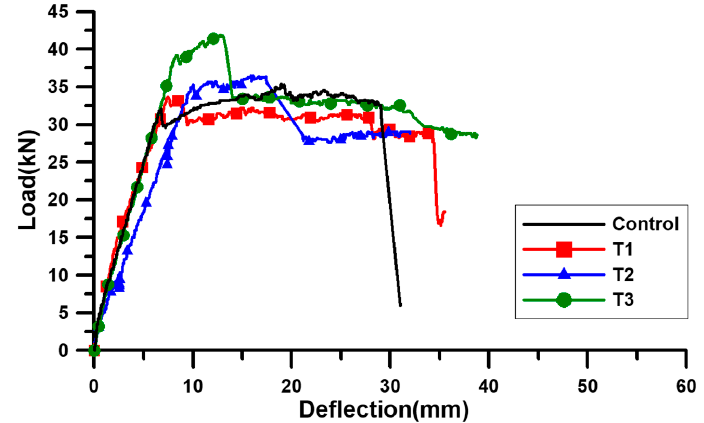
Figure 8. Load and deflection curve: Textile reinforced ratio.